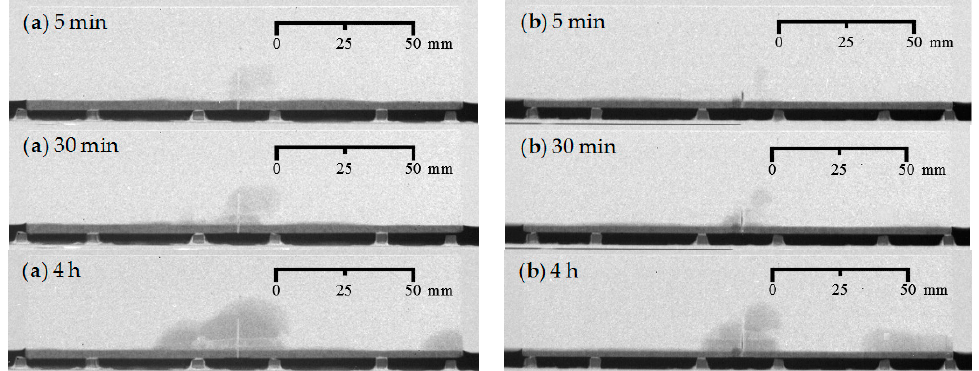
Figure 7. Visualization of the water uptake as a function of exposure time using neutron radiography for mortar prisms with one crack healed: ( a ) crack healing with PU_HV (representative sample: CR_1_PU_HV_A); and ( b ) crack healing with PU_LV (representative sample: